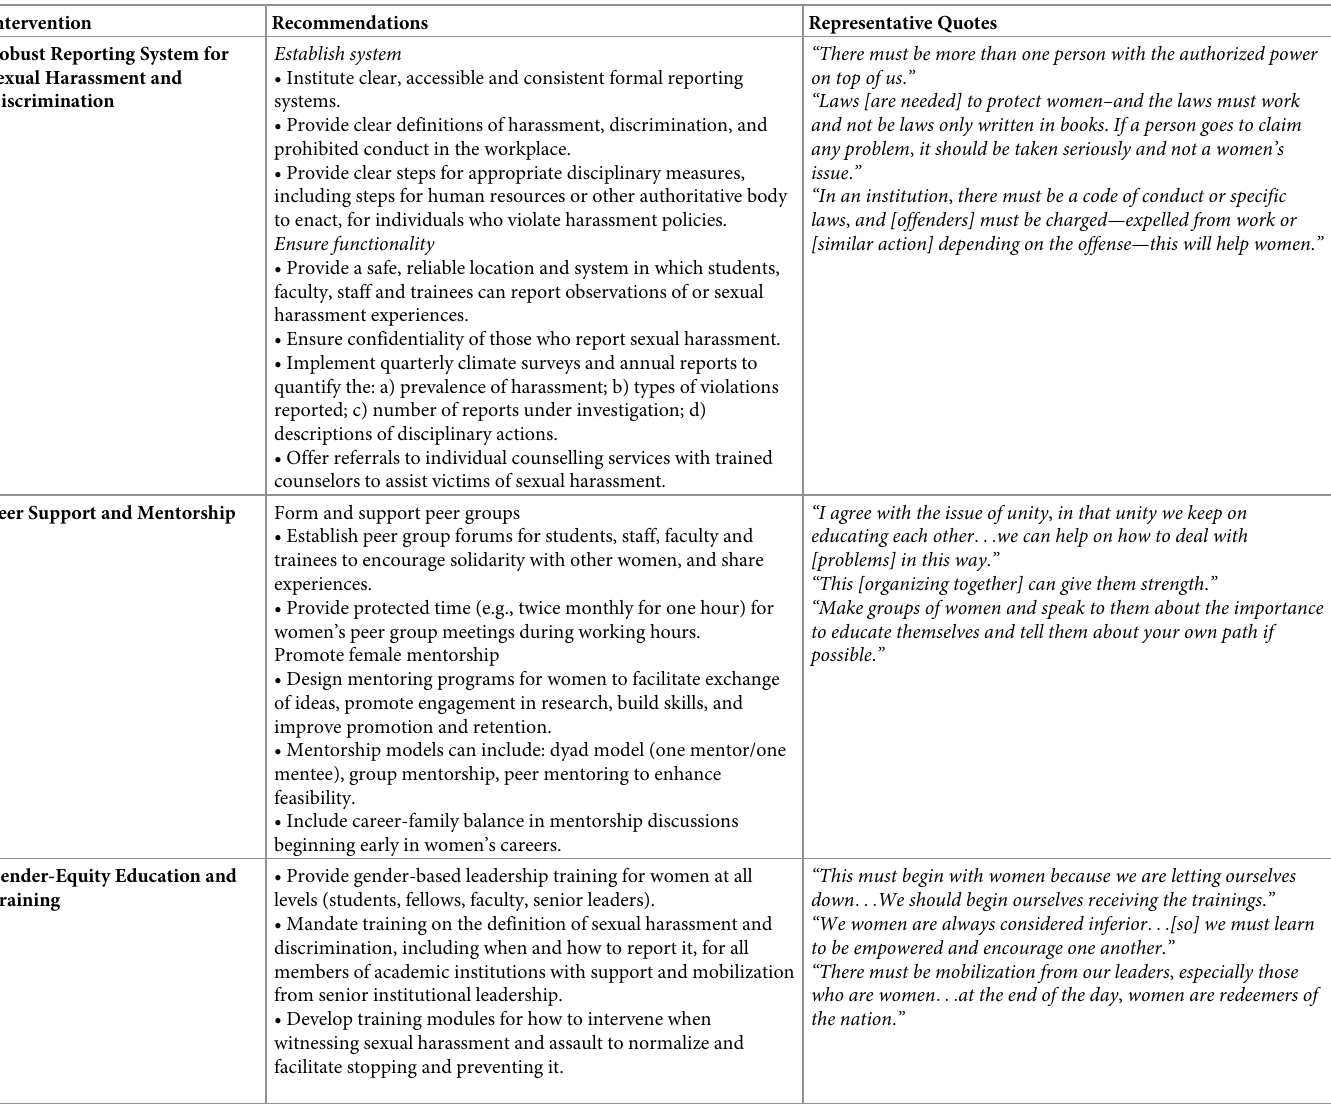
Table 2. Women’s recommendations for interventions to address gender-based